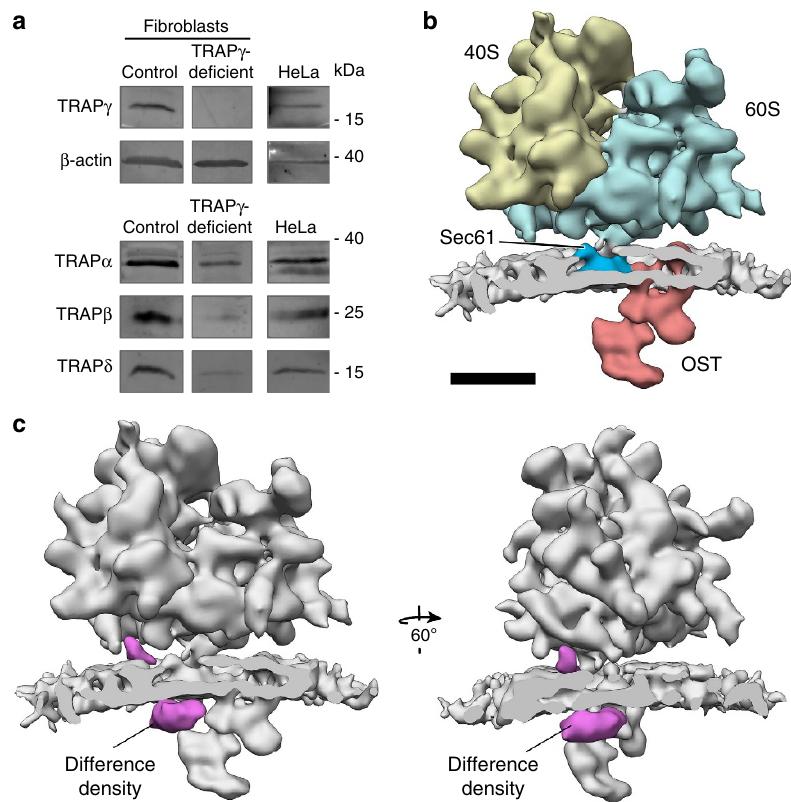
Figure 3 | TRAP is destabilized in TRAP c -deficient patient fibroblasts. ( a ) Western blot analysis of control and TRAP g -deficient patient primary fibroblasts. HeLa cells were used as positive control for the TRAP antibodies. Please note that bands for HeLa cells and control fibroblasts are duplicated with Fig. 2a because samples were run on the same gel. ( b ) Subtomogram average of the ER-associated ribosome from TRAP g -deficient primary fibroblasts, including the large (blue) and small (yellow) ribosomal subunits, the membrane bilayer (grey), the Sec61 protein-conducting channel (dark blue) and OST (red). A total of 663 subtomograms were averaged. Scale bar, 10nm. ( c ) The difference density map (magenta) between the TRAP g -deficient and wild-type mammalian translocons is superimposed on the subtomogram average